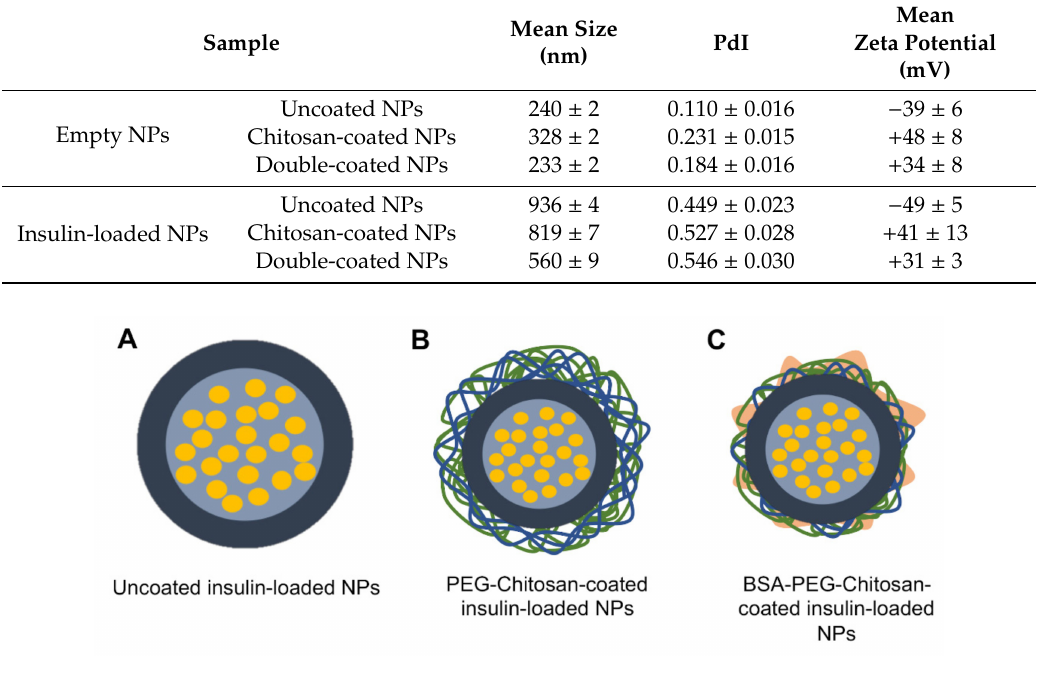
Figure 1. Double-coated insulin-loaded nanoparticles (NPs) throughout the formulation and coating processes: ( A ) uncoated insulin-loaded poly (D, L-lactic-co-glycolic acid) (PLGA) NPs; ( B ) chitosan-coated insulin-loaded PLGA NPs; and ( C ) double-coated insulin-loaded PLGA NPs.